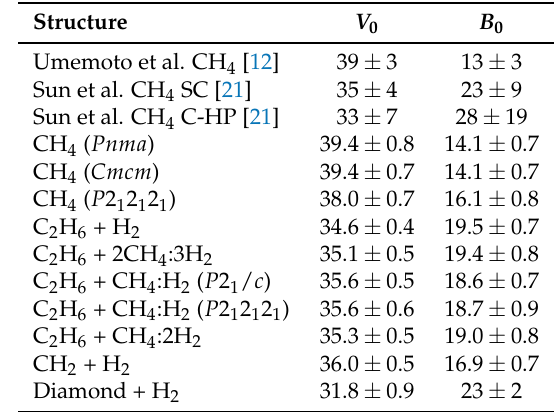
Table A1. Birch-Murnaghan equations of state fit parameters for experimental and theoretical phases of CH 4 stoichiometry. All values are normalised per unit of CH 4 . For example, the “Diamond + H 2 ” volume V 0 corresponds to V 0 = V 0 ( C-dia ) + 2 V 0 ( H 2 ) . Errors are associated with 90% confidence limits of